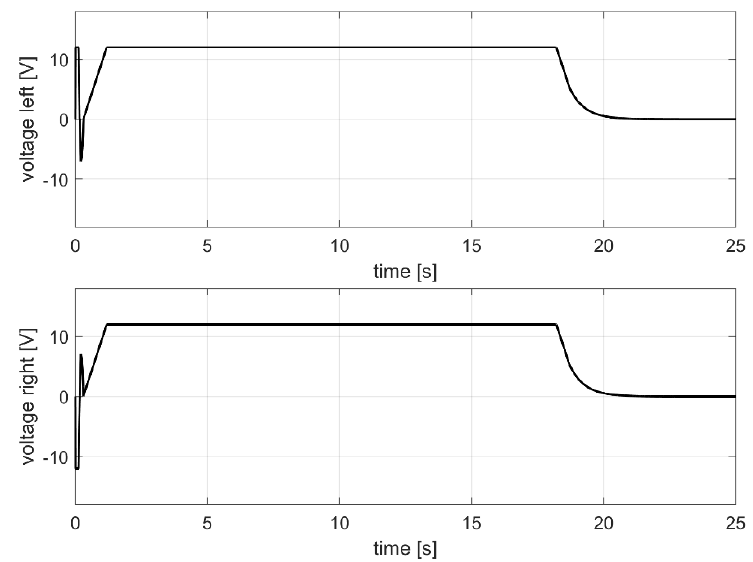
Figure 4. Example of input voltages to the right and left sides for rover control.